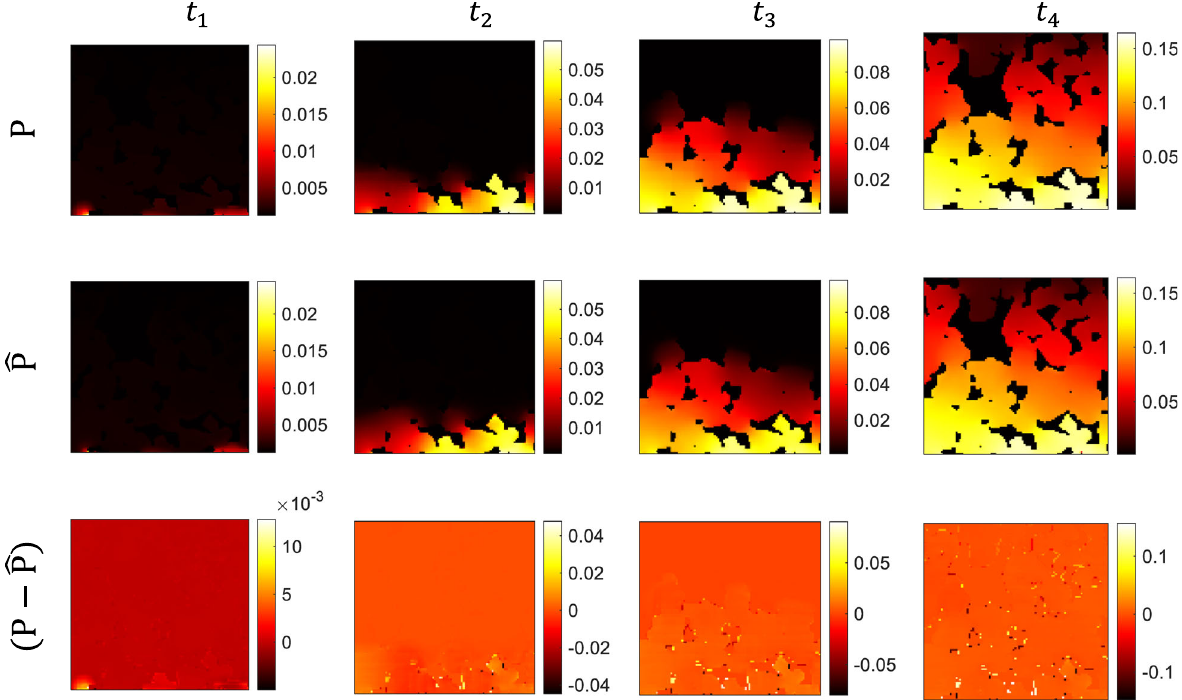
Fig. 3 Prediction of the pressure fi eld by the trained PIRED. Comparison of the predicted pressure ^ P with the numerically calculated P at four (dimensionless)